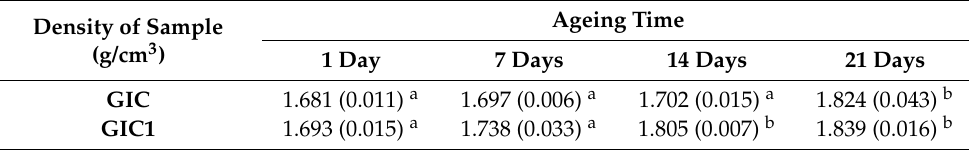
Figure 1. Density results of GIC and GIC1 samples at different ageing time (error bars indicate standard error). Table 1. Mean density along with the standard deviation (SD) of the GIC and GIC1 samples at different ageing